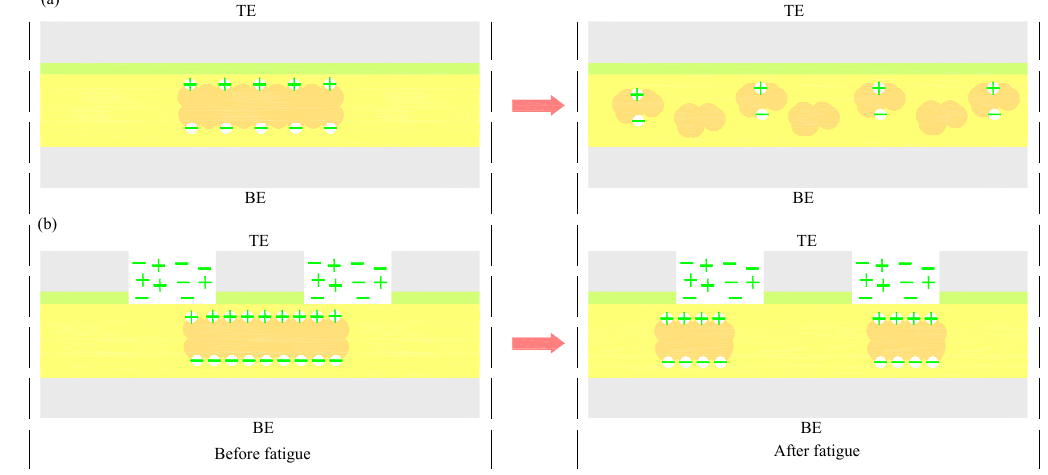
Figure 5. Schematic of polarization reversal fatigue progress. ( a ) Schematic of domain degradation progress without enough free charges; ( b ) Schematic of domain degradation progress with enough free charges.